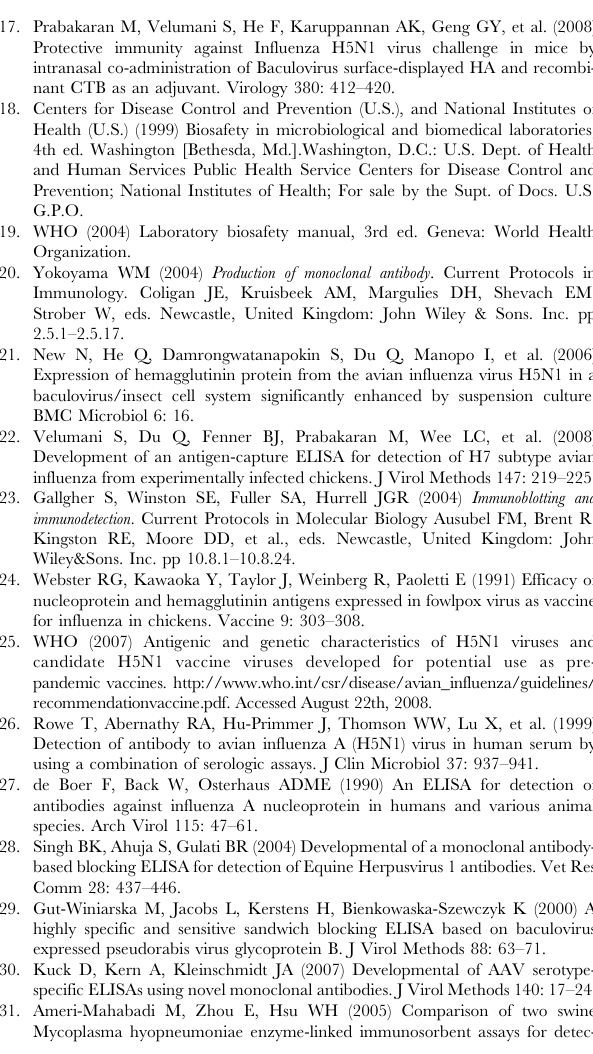
Found at: doi:10.1371/journal.pone.0004566.s004 (0.04